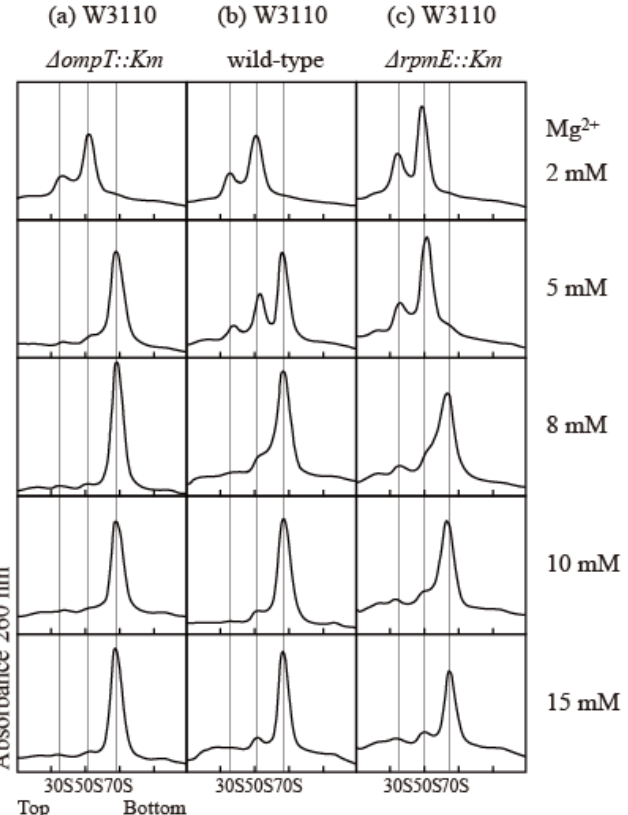
Figure 4. Influence of bL31 on ribosomal profiles upon SDG centrifugation. HSRs of W3110 Δ ompT::Km , wild-type, and Δ rpmE::Km cells were prepared and analyzed using 5–20% SDG centrifugation with the indicated Mg 2+ concentrations. The resultant ribosome profiles are shown. ( a ) W3110 Δ ompT::Km , ( b ) W3110 wild-type, and ( c ) W3110 Δ rpmE::Km . HSRs (60 pmol) were subjected to SDG centrifugation.